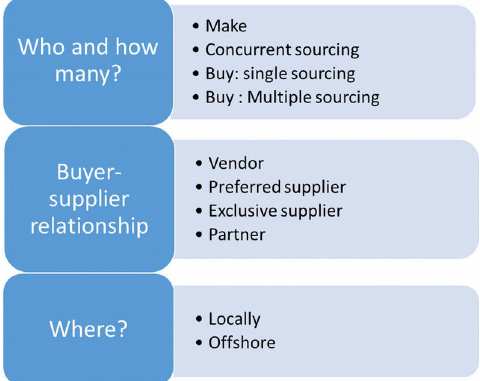
Figure 1. Alternatives for each